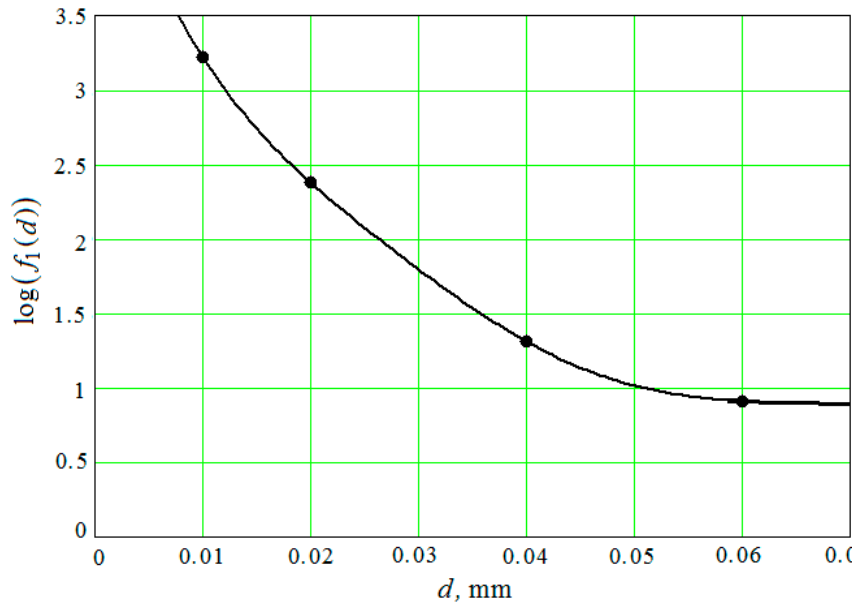
Figure 5. The decimal logarithm f 1 ( d ) (continuous curve) and the results of the numerical solution of Equation (41) (points).